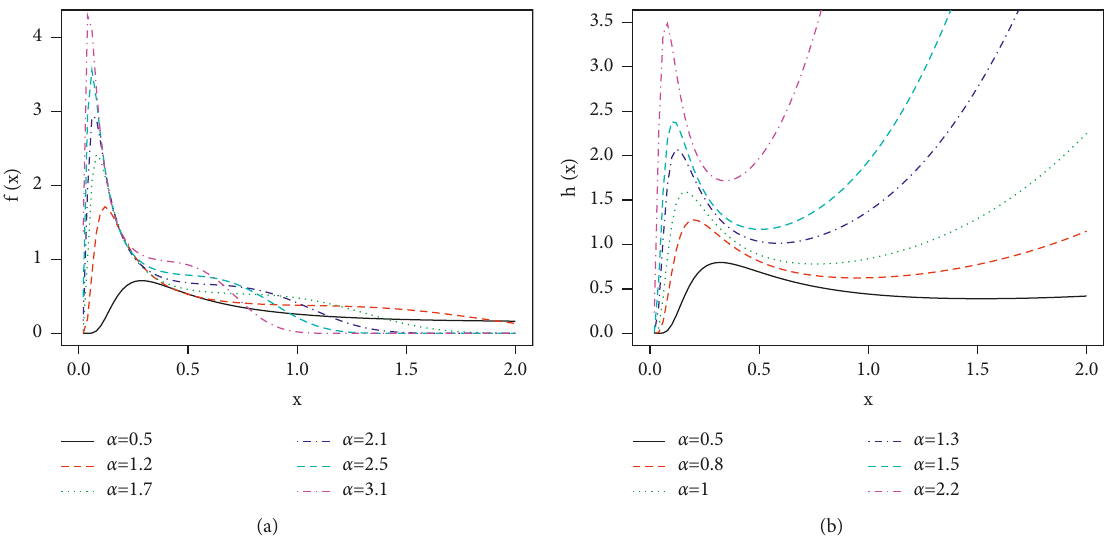
Figure 1: Graphical representation for the plots of the LCE: (a) density and (b) hazard rate function using certain values of the parameters.